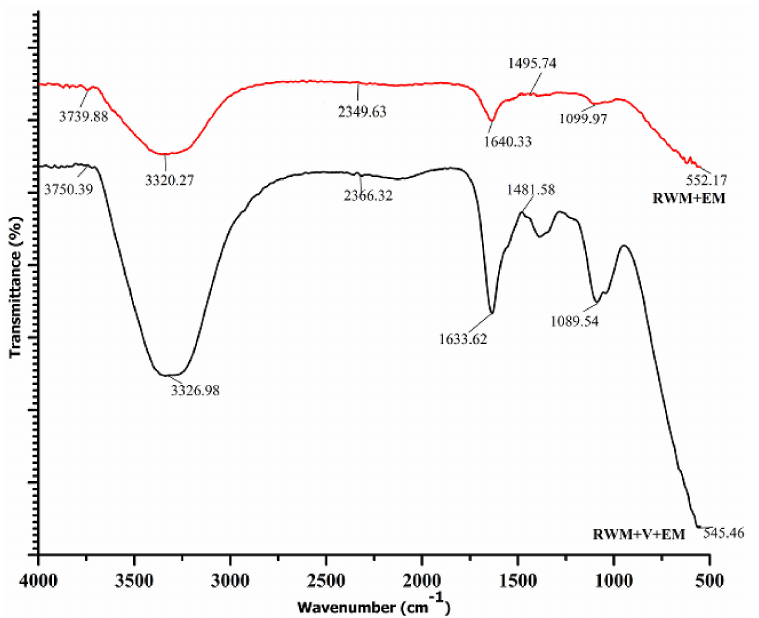
Figure 10. Variation of FTIR of the samples: [RWM +EM], [MW+EM], [MW+ V+EM], and [RWM+V+EM].